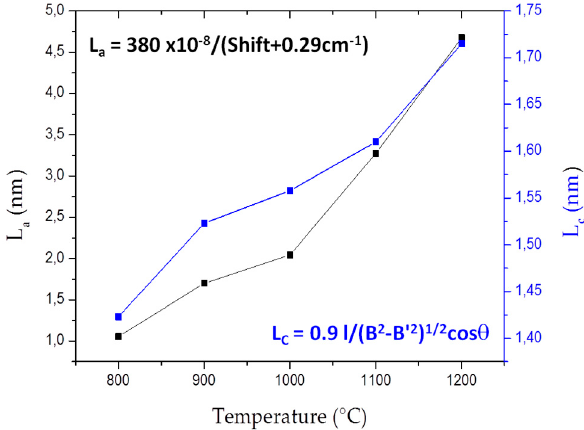
Figure 5. Graphs showing the evolution of L c (calculated from Sherrer’s equation) ( blue ) and L a (calculated from Nemanich’ correlation) ( black ) as function of the annealing temperature.